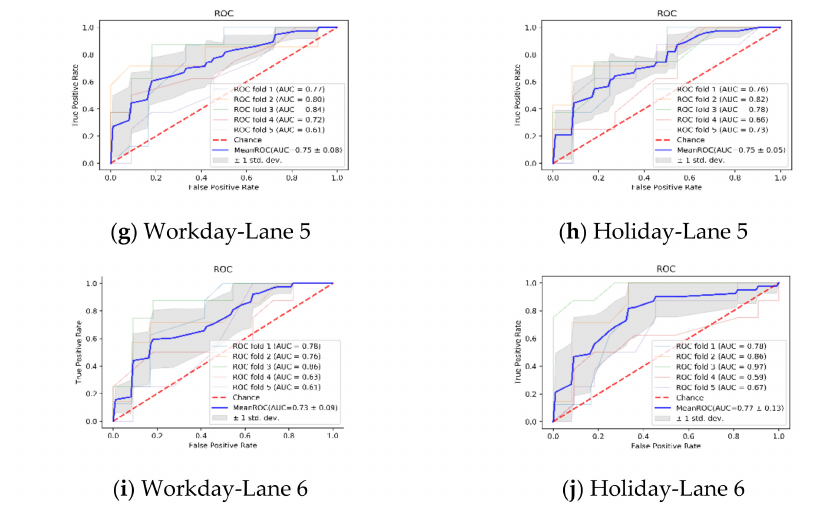
Figure 7. Cross validation and comparative analysis: ( a ) ROC curves of k-fold cross validation about lane 2 on workday, ( b ) ROC curves of k-fold cross validation about lane 2 on holiday, ( c ) ROC curves of k-fold cross validation about lane 3 on workday, ( d ) ROC curves of k-fold cross validation about lane 3 on holiday, ( e ) ROC curves of k-fold cross validation about lane 4 on workday, ( f ) ROC curves of k-fold cross validation about lane 4 on holiday, ( g ) ROC curves of k-fold cross validation about lane 5 on workday, ( h ) ROC curves of k-fold cross validation about lane 5 on holiday, ( i ) ROC curves of k-fold cross validation about lane 6 on workday, ( j ) ROC curves of k-fold cross validation about lane 6 on